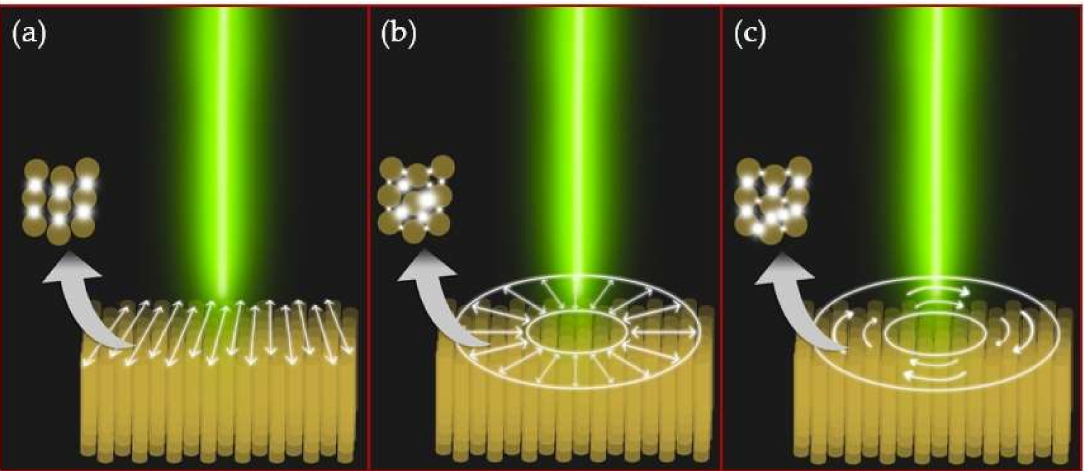
Figure 6. Schematic differences in collective plasmonic modes excited in the oligomeric structure of nanorods, depending on the polarization type: ( a ) linear, ( b ) radial and ( c ) azimuthal. The electric near-field is localized in narrow gaps between gold nanorods. The arrangement of hotspots depends on the spatial location of the oligomer in relation to the center of the laser beam in the case of radial or azimuthal